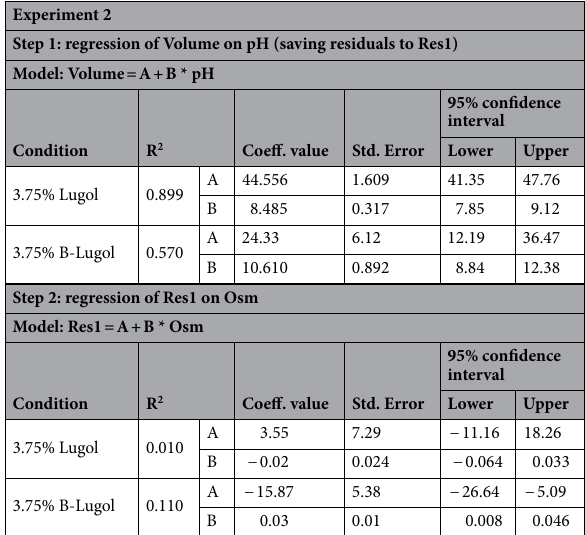
Table 2B. Stepwise regression analysis in Experiment 2. For description of the procedure: see Table 2A. Note that the intercepts (A) and slope coefficients (B) of the volume—pH relation show overlapping confidence intervals with those in the different conditions in Experiment 1, indicating that, even in B-Lugol a similar effect of pH on volume is present, but hardly any volume change is observed because the pH is almost